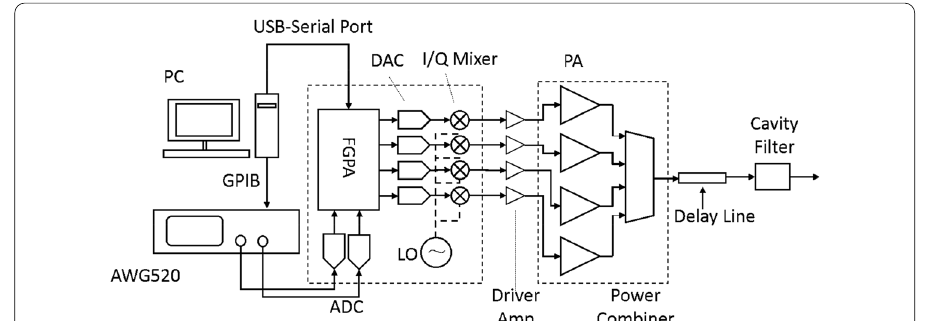
Fig. 13 Diagram of the complete CANE system setup. The delay line before cavity filter is for phase adjustment needed to maintain the power efficiency